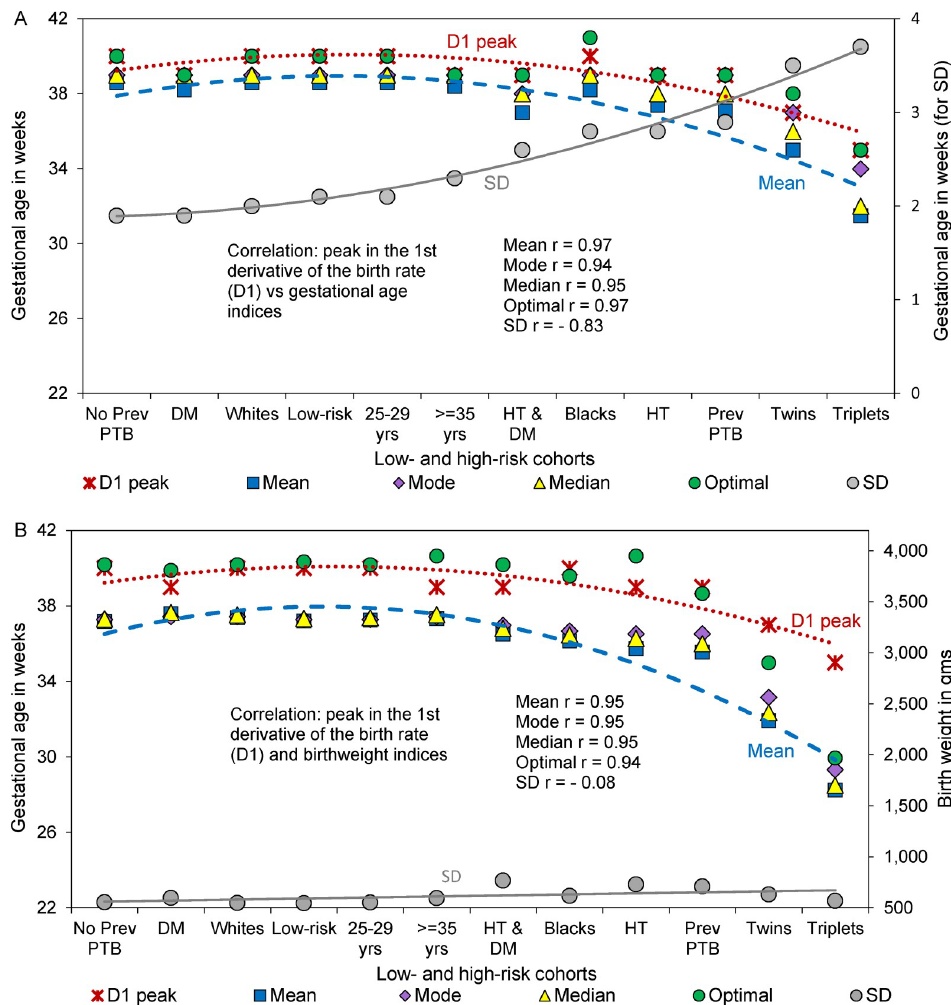
Fig 5. Clustering and correlation between the gestational age peak in the first derivative of the birth rate and the mean, mode and median of the gestational age distribution, optimal gestational age, and the standard deviation of the gestational age distribution (Panel A); and clustering and correlation between the gestational age peak in the first derivative of the birth rate and the mean, mode and median birthweight, optimal birthweight, and the standard deviation of the birthweight distribution (Panel B) among 12 low- and high-risk cohorts, United States, 2004–2015. (Cohort notations: No prev PTB denotes no previous preterm birth; DM, diabetes mellitus; Whites, White women; No HT-DM, singletons of women without hypertension or diabetes; 25–29 yrs, women 25–29 years of age; � 35 yrs, women � 35 years of age; HT & DM, hypertension and diabetes; Blacks, black women; HT, hypertension; and Prev PTB, previous preterm birth. Note: All series in Panel A are represented on the primary Y-axis except the SD of the gestational age distribution, which is represented on the secondary Y-axis. In Panel B, the D1 peak is represented on the primary Y-axis and all other series are on the secondary